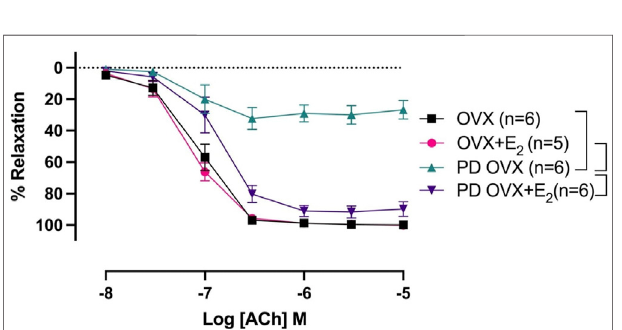
FIGURE3 | Concentration-responsecurve(CRC) toacetylcholine (ACh, 10 − 8 to 10 − 5 M) in intact mesenteric arterial rings precontracted with phenylephrine (PE, 2 μ M) from ovariectomized (OVX) and E 2 replaced (OVX+E 2 )controland prediabetic(PD)rats.Dataareexpressed asmean ± SEM. n = 5 – 6 animals per group. Brackets indicate signi fi cant differences between groups ( p < 0.05), analyzed using 2-way ANOVA with repeated measures followed by Tukey ’ s post hoc test.